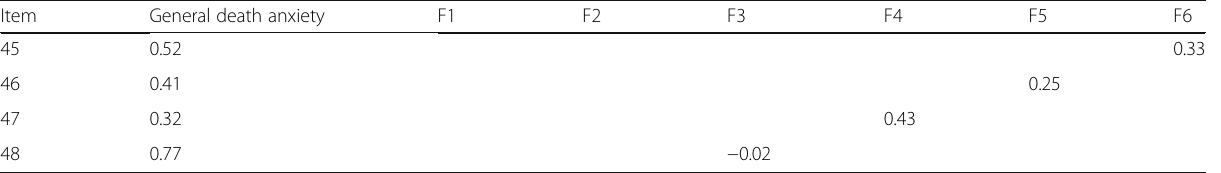
Table 1 Standardised factor loadings from the bi-factor model of the FVTS (Continued)